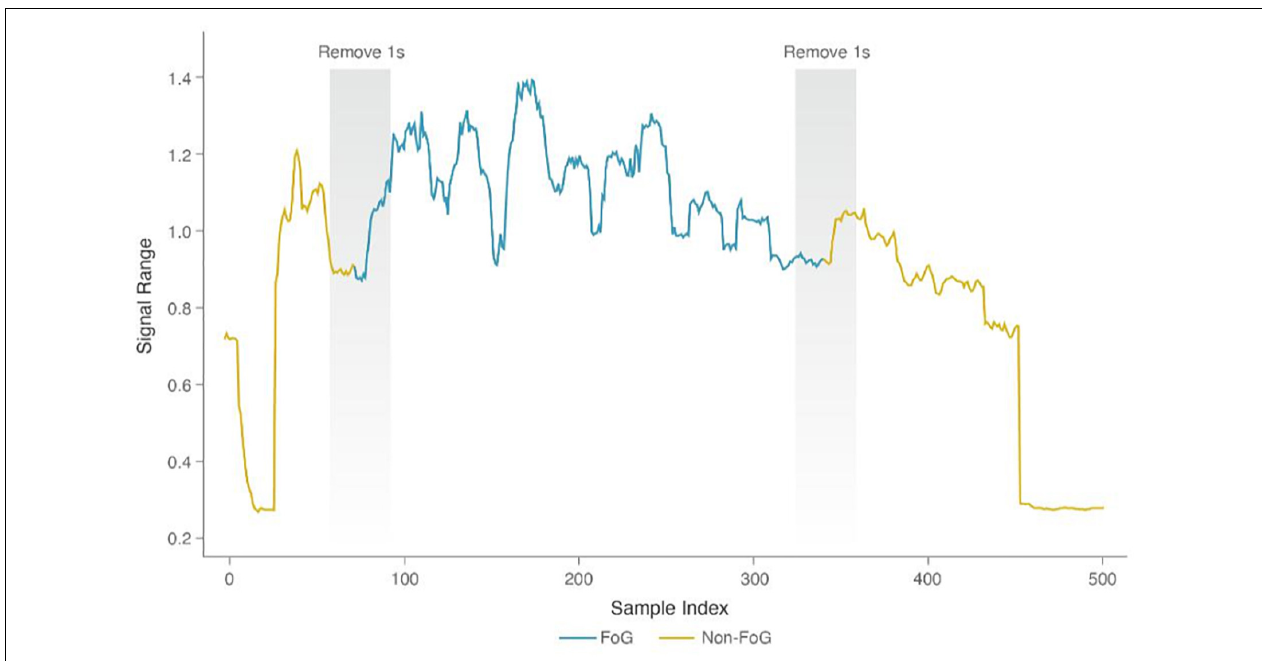
FIGURE 4 | Removal of the transition samples between FOG and non-FOG.